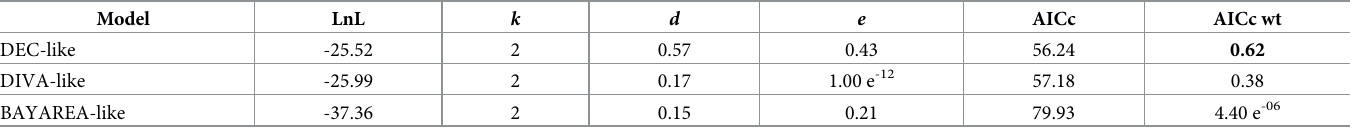
Table 1. Parameter estimates of the three biogeographic models